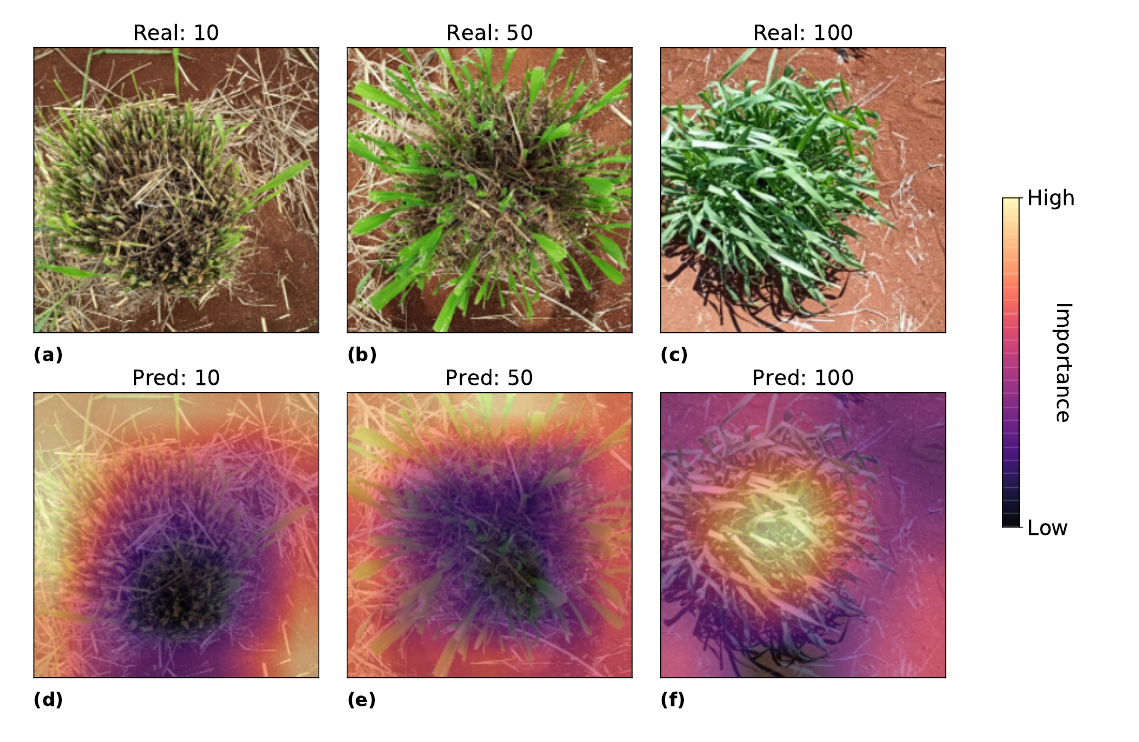
Figure 10. Grad-Cam analysis of the best predictions. Figures ( a – c ) represents the real image with true score of 10, 50 and 100. Figures ( d – f ) represent the activation maps where the model predicted 10, 50, 100.